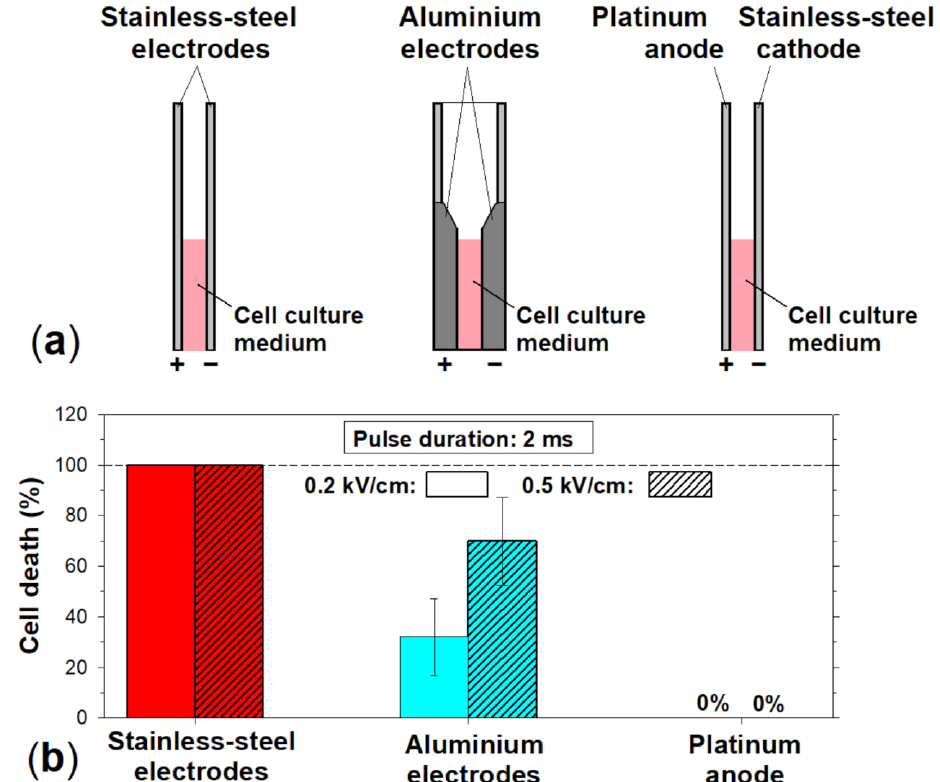
Figure 4. Influence of the electrode material on the cytotoxicity of the culture medium treated with an electric pulse. ( a ) Three different combinations of electrodes that were used: (1) stainless steel anode and cathode, (2) aluminum anode and cathode, and (3) platinum anode and stainless steel cathode. ( b ) The fraction of the mouse hepatoma MH-22A cells, which died in the medium treated with a square-wave electric pulse. In all cases, the pulse duration was 2 ms and the amplitude